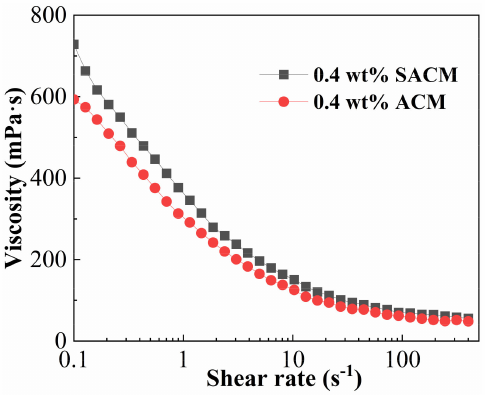
Figure 6. Effect of shear rate on viscosity of suspension diluent and powder